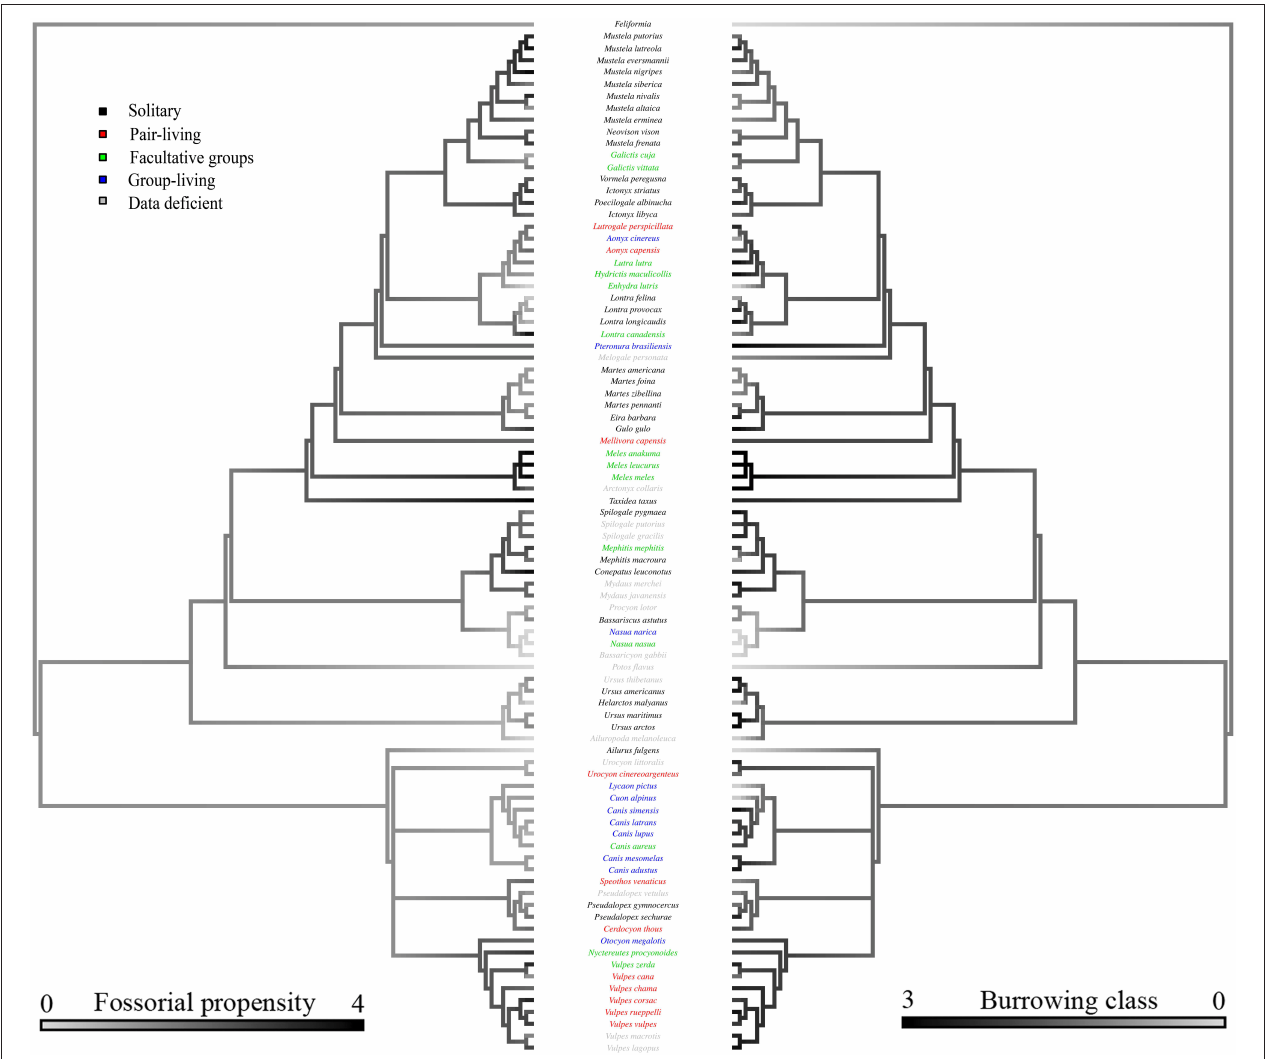
FIGURE 2 | Consensus tree of the Caniformia based on phylogenetic relationships from Agnarsson et al. (2010). Relationships between the Canidae were taken from Lindblad-Toh et al. (2005). For clarity, the Feliformia are collapsed. Shading of the left hand branches depicts fossorial propensity scaled from wholly epigean, to wholly fossorial. Shading of the right hand branch depicts burrowing class scaled from no burrow use, to primary excavators. Coloration of species labels denotes group-living propensity, classified as: (black) solitary: species with predominantly solitary life-histories; (red) pair-living: predominantly pair-living species; (green) facultative groups: species with both solitary and group-living life-histories, variable across populations; and (blue) group-living: species exhibiting obligate groups. Data deficient species are listed in